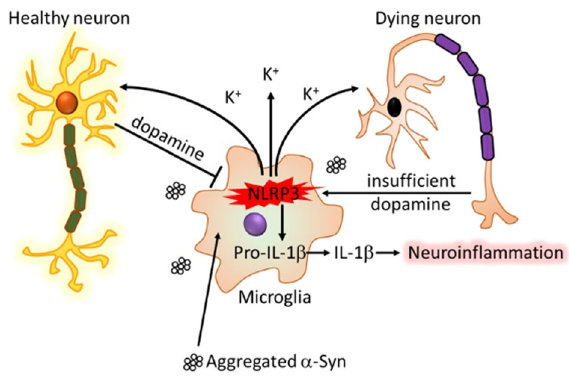
Fig. 1 Proposed convergence of NLRP3 in fl ammasome, K + fl ux, and dopamine mechanisms to elicit PD pathology. α -Syn binds to surface receptors and is taken up by microglia, leading to Kv1.3 (possibly assisted by other K + channels) -mediated K + ef fl ux signaling for the activation of the NLRP3 in fl ammasome and caspase-1. The ef fl ux of K + could provoke K + channel-mediated or toxicity-induced release of dopamine from proximal dopaminergic neurons. Dopamine could then bind to its receptors on microglia to curb activation of the in fl ammasome. Suf fi cient DA in the system would keep this interaction under control, but if DA is depleted over time by the microglia, the imbalance could allow for the progression of in fl ammasome-associated α -syn aggregation, neuroin fl ammation, and neurotoxicity, and thus PD